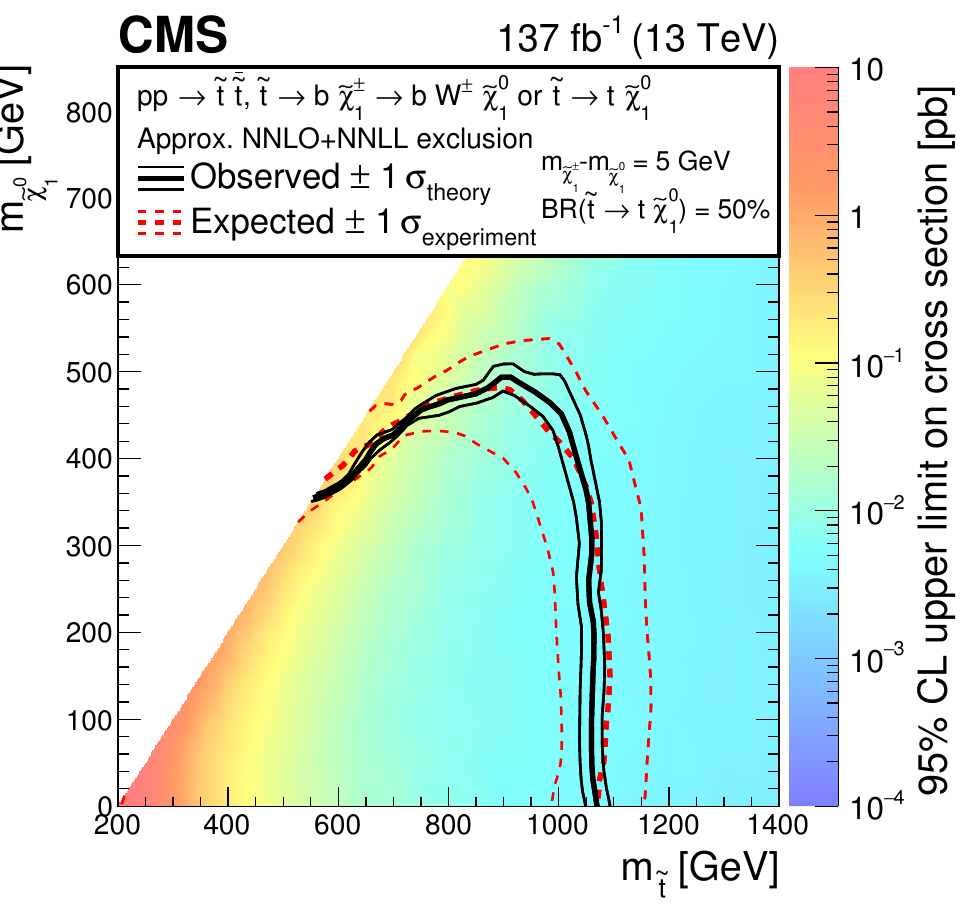
Figure 8 . Exclusion limits at 95% CL for the pp ! scenario. The mass di(cid:11)erence between the (cid:31) 0 is taken to be 5 GeV. The colored map illustrates the 1 95% CL upper limits on the product of the production cross section and branching fraction. The area enclosed by the thick black curve represents the observed exclusion region, and that enclosed by the thick, dashed red curve represents the expected exclusion. The thin dotted (red) curves indicate the region containing 68% of the distribution of limits expected under the background-only hypothesis. The thin solid (black) curves show the change in the observed limit by varying the signal cross sections within their theoretical